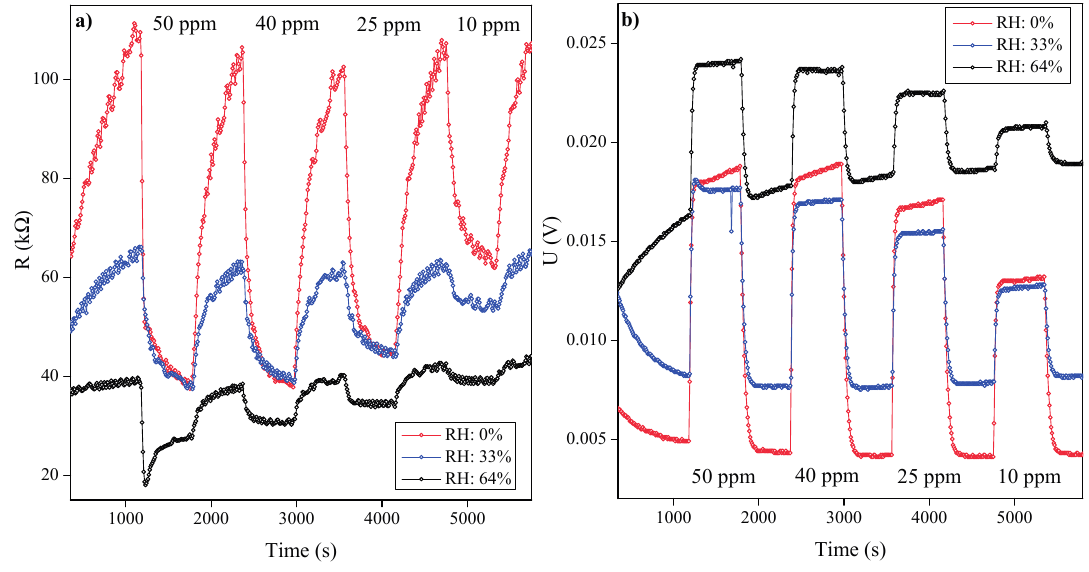
Figure 3. Response and recovery measurements of ( a ) MQ-3 sensor measured in the resistivity mode; and ( b ) MiCS-5914 sensor measured in the voltage mode, at different relative